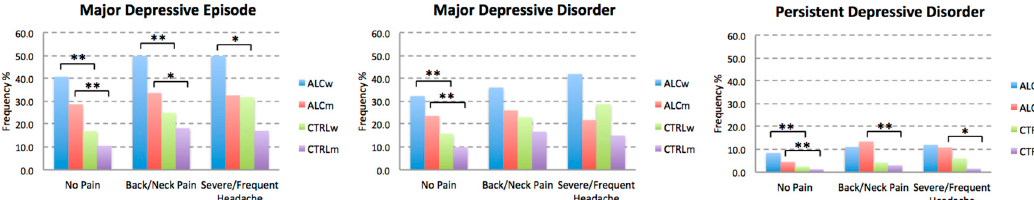
Figure 3. Breakdown of Depressive Disorders by Sex. The plots represent the lifetime incidence of depressive disorders in individuals with no chronic pain (i.e., No Pain, Chronic Back / Neck Problems, or Frequent / Severe Headaches) with or without a history of alcohol abuse. CTRL refers to individuals with no history of alcohol abuse. Abbreviations: ALCw, women with alcohol abuse history; ALCm, men with alcohol abuse history; CTRLw, control women; CTRLm, control men. * p < 0.0166, ** p < 0.0033, adjusted thresholds with Bonferroni correction for three comparisons for the three depressive disorders.